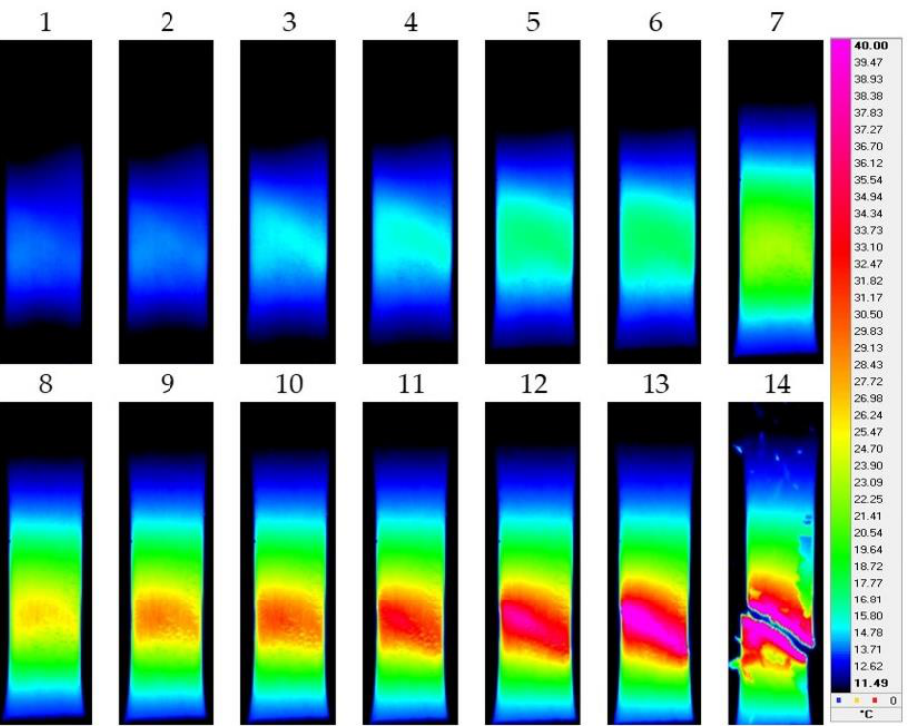
Figure 6. IR thermograms of a deformed sample of the Ti-45Nb alloy in the UFG state: 1 — ε = 0.055; 2 — ε = 0.057; 3 — ε = 0.06; 4 — ε = 0.062; 5 — ε = 0.064; 6 — ε = 0.065; 7 — ε = 0.066; 8 — ε = 0.067; 9 — ε = 0.068; 10 — ε = 0.069; 11 — ε = 0.07; 12 — ε = 0.073; 13 — ε = 0.075; 14 — ε = 0.08.